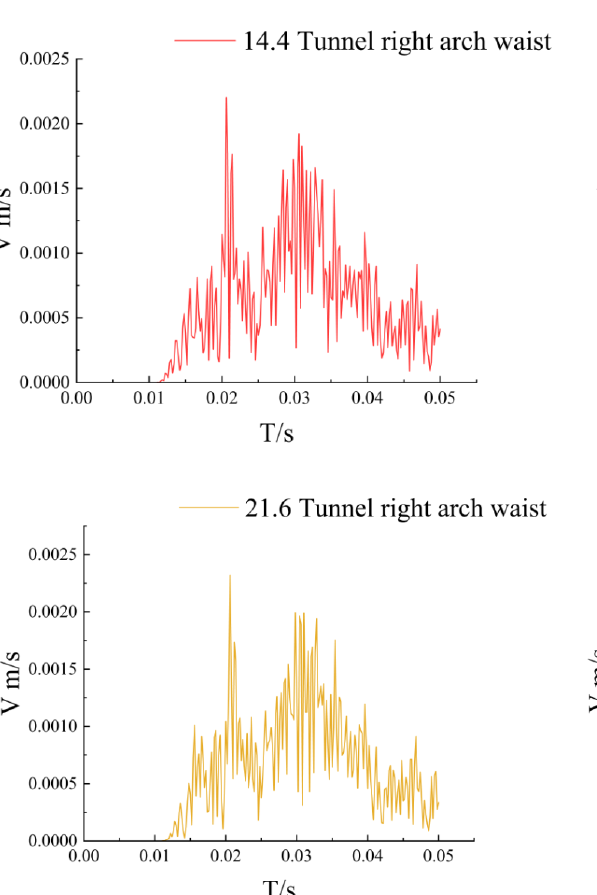
Figure 11. Vibration velocity curve of right arch shoulder of steel fiber concrete tunnel.